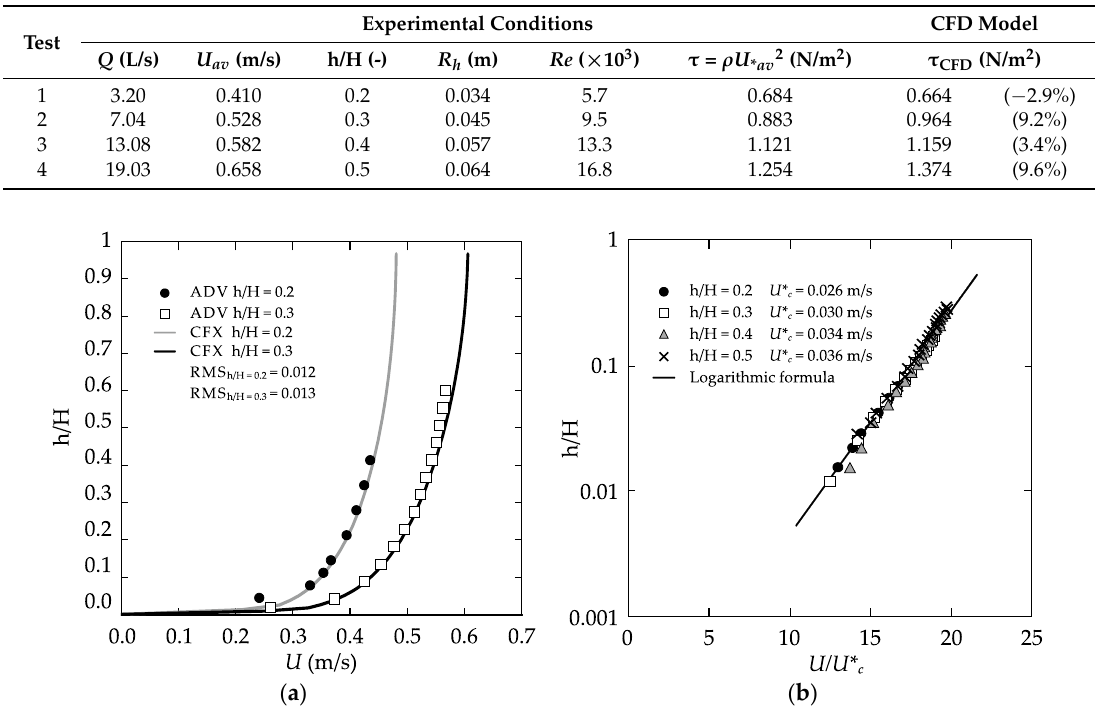
Figure 3. ( a ) Experimental and numerical comparison of velocity profiles for a filling ratio of h/H = 0.2 and 0.3 and ( b ) results of fitting Equation (2) to all test using U *c for normalizing.